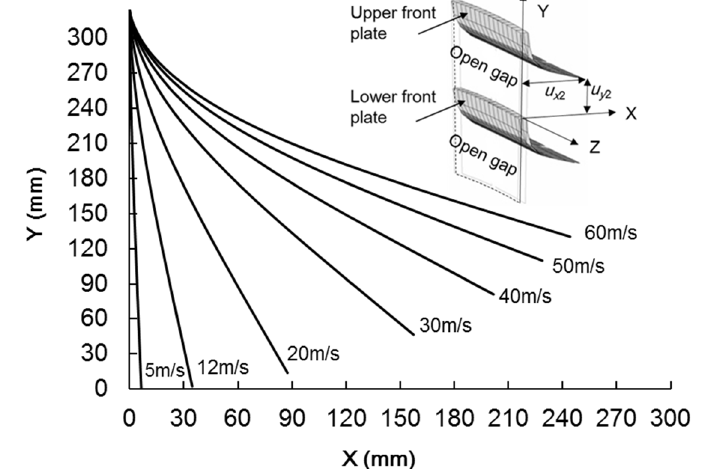
Figure 16. Distributions of wind velocity on the rotor planes, at 60 m/s, of two flanged diffusers with a rigid and flat flange and with a bended self-adaptive flange, respectively.